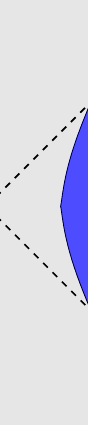
Figure 29 . Left: The ETW brane in global AdS. For T > 0 we have the geometry on the left of the brane. For T > 0, we have the geometry on the right of the brane. Diagonal planar surfaces are Rindler horizons dividing the spacetime into complementary Rindler wedges plus past and future p regions. Right: dependence of the radial position parameter (cid:24) = r 2 (cid:0) 1 on Schwarzschild time (cid:16) .